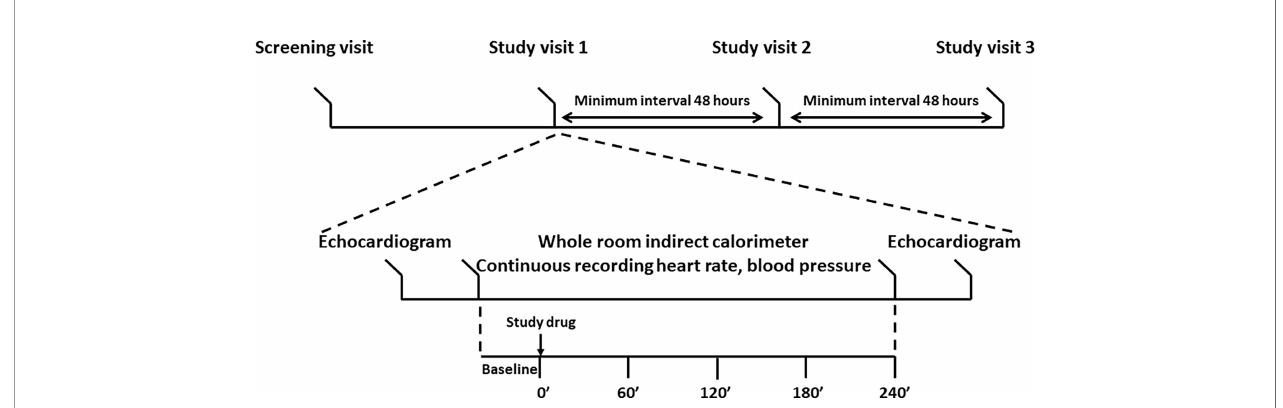
FIGURE 2 | Study design. Top panel: timeline of the study. After enrollment, study volunteers underwent three identical visits each separated by at least 48 hours. Bottom panel: study procedures. An echocardiogram was performed upon arrival to the Clinical Research Services Unit and after completion of the stay in the whole room indirect calorimeter. Energy expenditure was recorded for at least 30 ’ before the administration of the study drug or placebo. Five blood samples were collected to record the LT4 and LT3 pharmacokinetics. Blood pressure, heart rate, and hemodynamics data were collected throughout the stay in the whole room